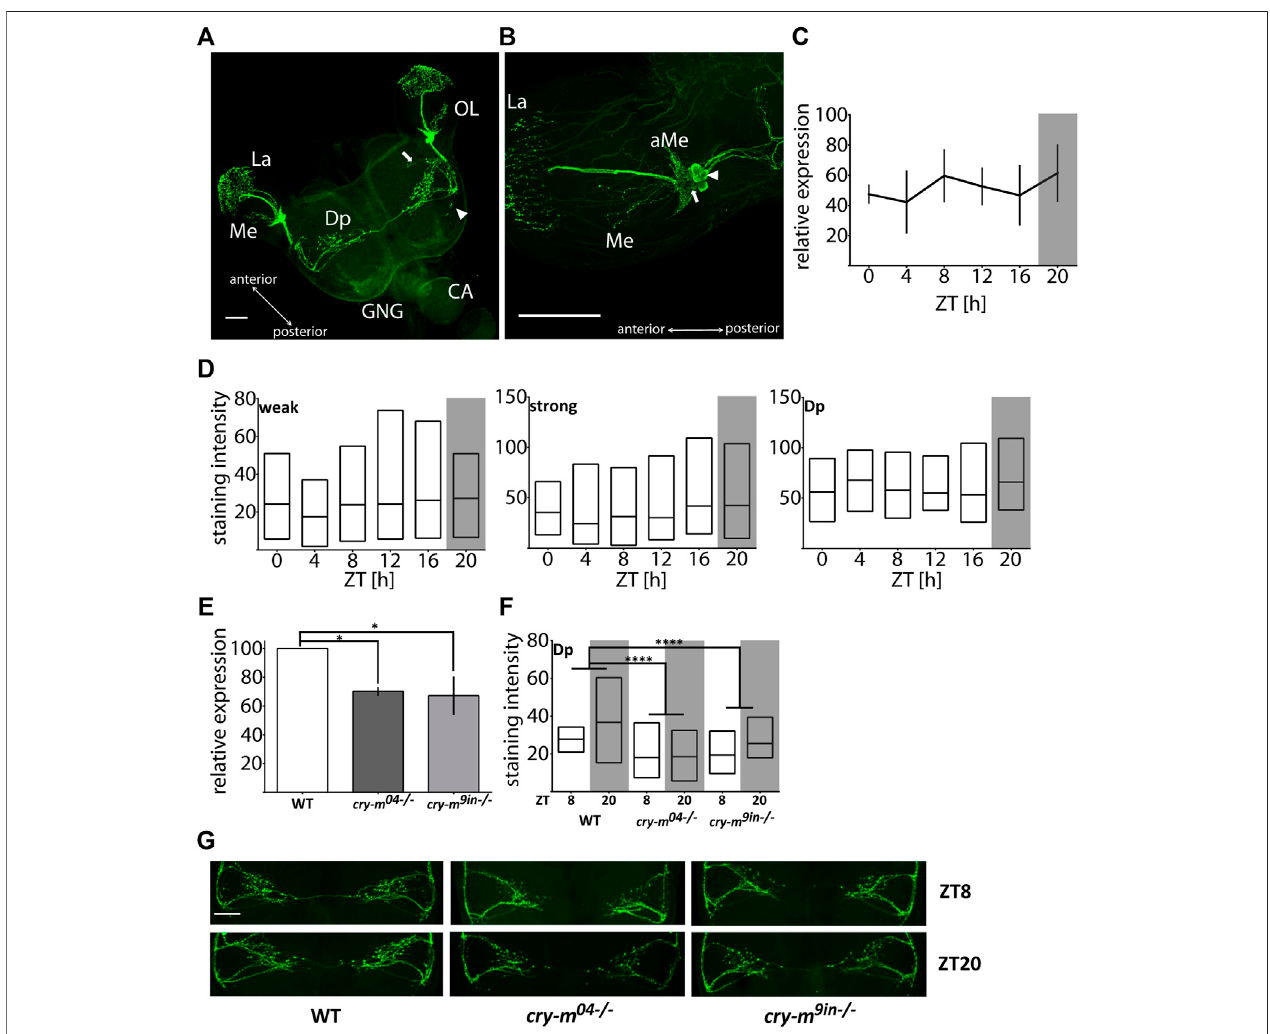
FIGURE1| AnalysisofthePDFmRNAandproteinlevelsinWTand cry-m LDmales. (A) LocalizationofPDFin P.apterus brain( see thetextfordetaileddescription). Arrow pointstotheneuronal branchextendingfromtheanteriordorsal fi berandarrowheadpointstotheneuronalextension oftheposteriordorsal fi ber. (B) Localization of PDF in the optic lobe. Two groups of cells can be distinguished: weakly (arrow) and strongly (arrowhead) stained cells. OL, optic lobe; GNG, gnathal ganglion; CA, corporaallata;La,Lamina;Me,medulla;Dp,dorsalprotocerebrum;aMe,accessorymedulla,scalebar,100 μ m. (C) Expressionof pdf mRNAaroundthedayinLD males ( n = 3 independent repeats, error bar ± SEM). (D) PDF-immunostaining intensity over the day in weakly (weak) and strongly (strong) stained cells and dorsal protocerebrumarborizations(Dp)inLDmales( n =14 – 19foreachtimepoint).Floatingbarsrepresentmintomaxvalueswiththelineatmean. (E) Expressionof pdf in cry- m mutants(t-test(*) p < 0.05)( n =3independentrepeats,errorbar±SEM). (F) PDF-immunostainingintensityinDparborizationsin cry-m nullmutants(Two-WayANOVA genotypeeffect p < 0.0001,Tukey ’ s post-hoc (****) p < 0.0001, n for:WT=18, cry-m 04 − / − =27, cry-m 9in − / − =9).Floatingbarsrepresentmintomaxvalueswiththelineat mean. (G) Representative images of PDF-ir Dp arborization in WT and cry-m mutants. Grey rectangles on graphs depict darkness.